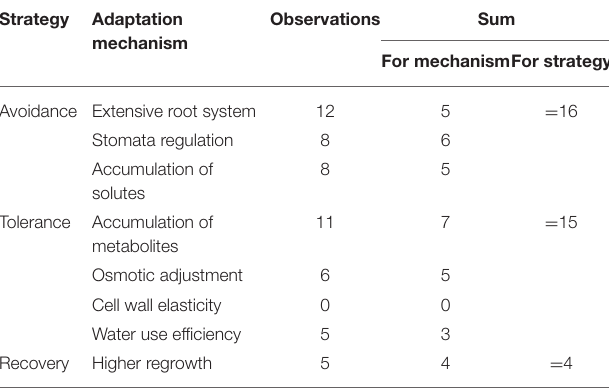
TABLE 2 | Summary table showing adaptation mechanisms for the different strategies plant may use to withstand drought conditions ( sensu Malinowski and Belesky, 2019) and that can be modulated by Epichloë fungal